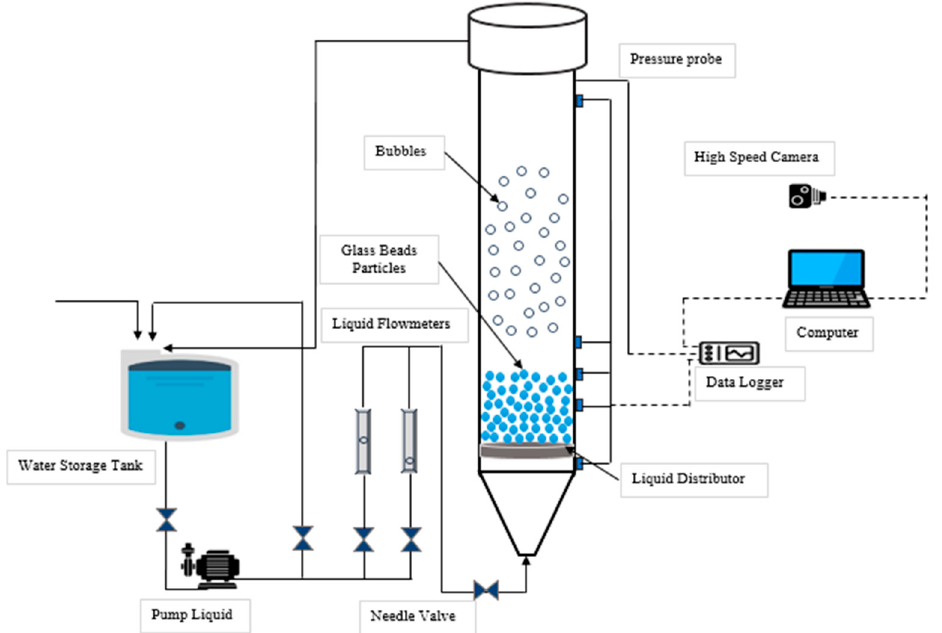
Figure 1. Schematic diagram of the experimental rig. Table 2. The experimental data used in this